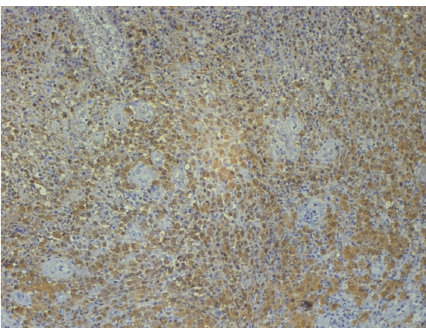
Figure 2: Immunostain specific S-100 positivity on immunohisto-